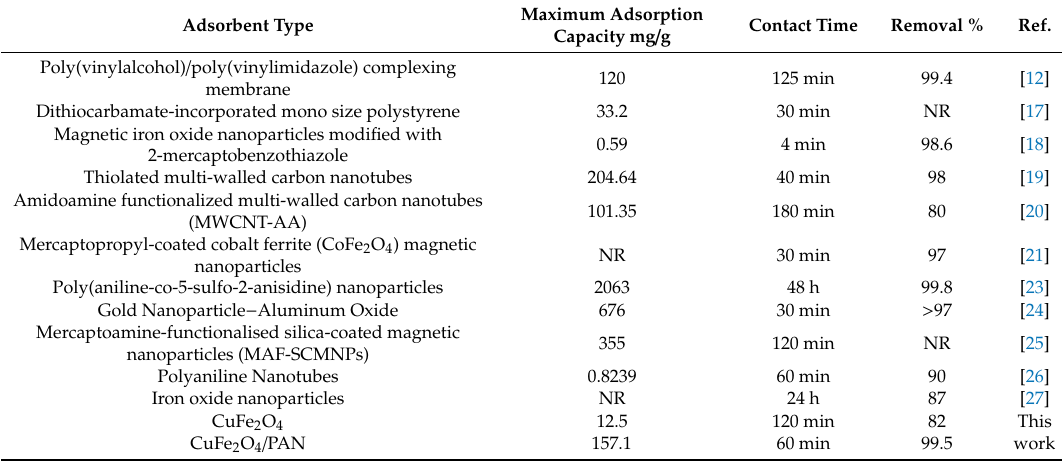
Table 4. Some materials used for the removal of mercuric ion.